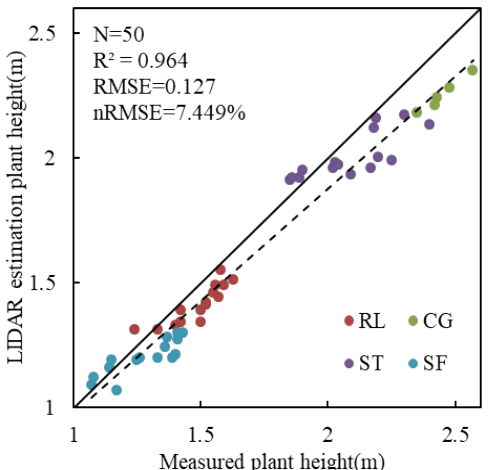
Figure 9. Comparison between measured plant height and LiDAR estimation plant height. Note: CG: control group; ST: stem tilt; SF: stem folding; RL: root lodging.